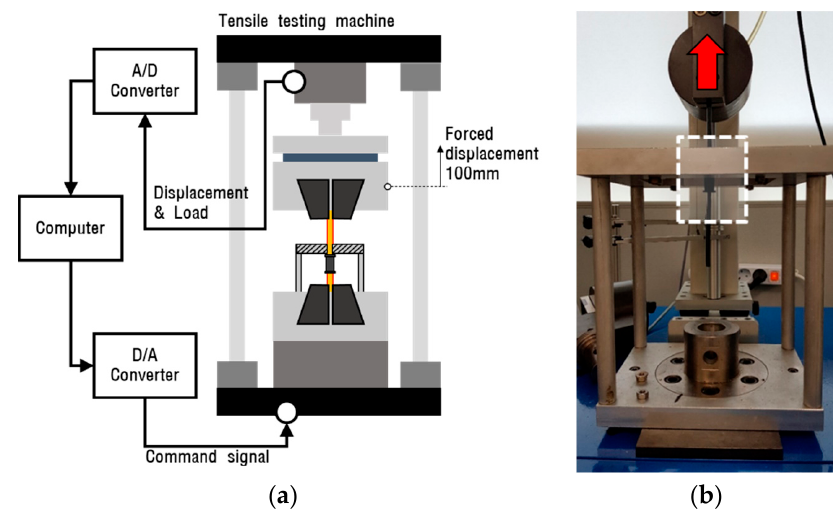
Figure 10. Overview of the tensile test required for the bonding force test. ( a ) Schematic of the grommet